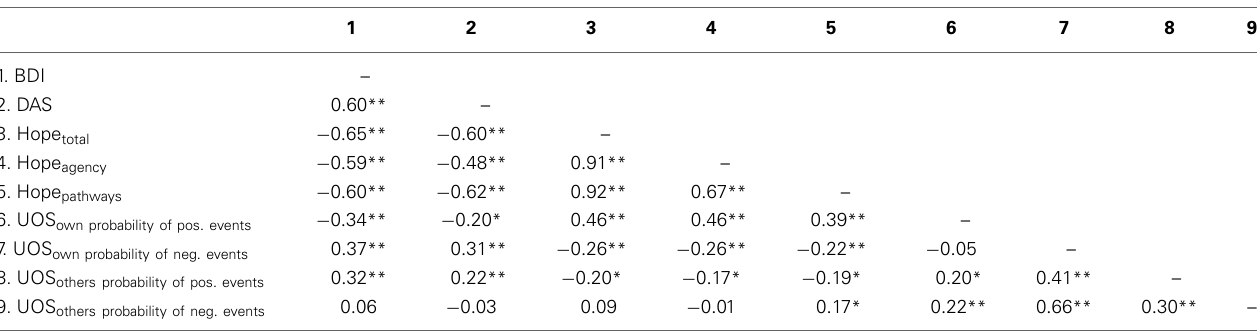
Table 2 | Correlations between the BDI, DAS, UOS, and Hope Scale in the total